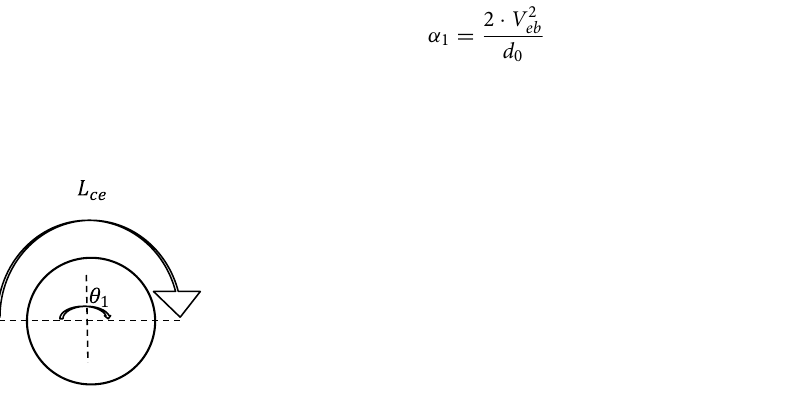
Figure 10. Diagram of head pulley/belt